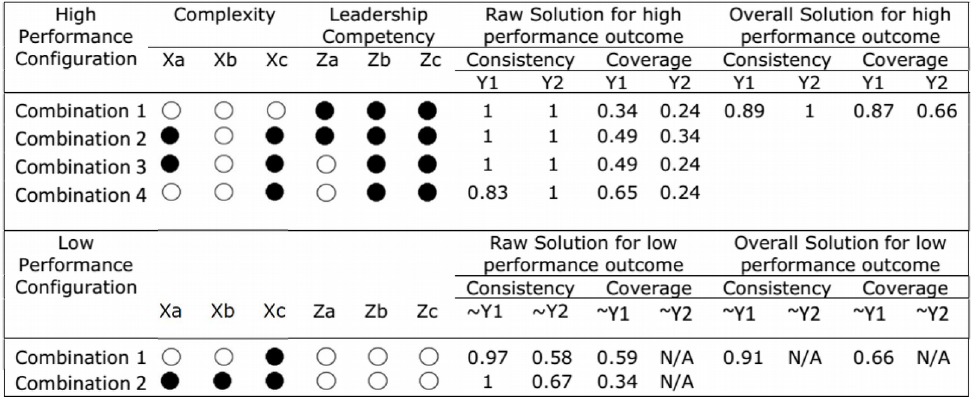
Figure 3. The Configurational